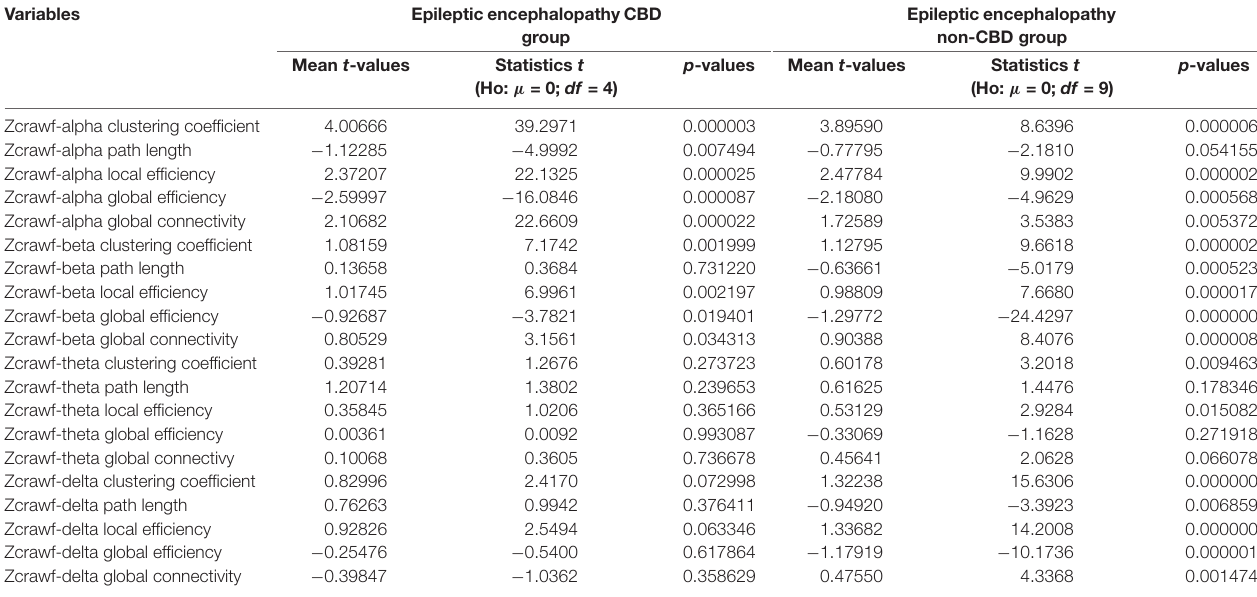
TABLE 2 | Statistical differences ( t -test) between graph theory measures of encephalopathy epileptic patients and healthy control sample based on the z individual value for each subject (Crawford’s approach). Variables EpilepticencephalopathyCBD